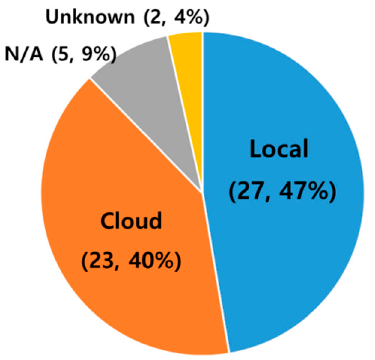
Figure 17. Number and ratio of studies by data-processing method of smart Figure 18. Number and ratio of studies by data-processing method of smart glasses.